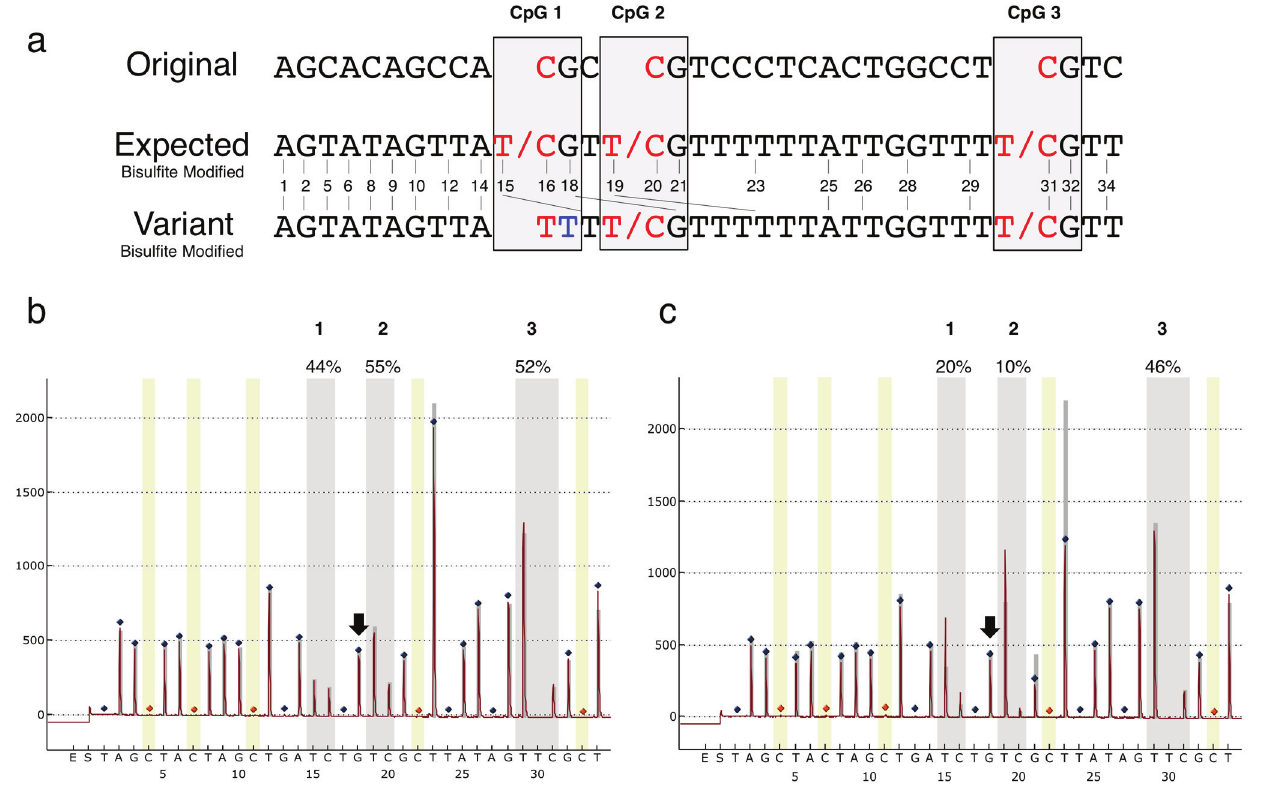
Figure 1. ( a ) The original sequence of interest for the IGF2 DMR region and the expected sequence from the bisulfite modified DNA and pyrosequencing, alongside the sequence for the variant allele. The three CpG dinucleotides are labeled; ( b ) Pyrogram obtained for an individual with wild type alleles; ( c ) Pyrogram from an individual with the variant allele, showing low methylation of CpG position 1 and a much higher than expected incorporation of T nucleotides at CpG 2 (position 19) due to the creation of a 3–4 base mononucleotide stretch of T residues. The number of T residues incorporated depends on the methylation status of the second CpG cytosine. This leads to premature incorporation of the downstream T nucleotides at position 19, early incorporation of the downstream G at position 21 instead at position 18 on the variant allele and as consequence only half the anticipated G height at the subsequent G at position 21, and lower than expected peak height for the Ts at position 23 since those on the variant allele had been incorporated at position 19. This also results in inaccuracy for the methylation status of the second CpG (site 20). The % methylation measured is indicated above each CpG cytosine. CpG cytosine positions are indicated by the grey vertical bars. Blue diamonds, non-variable reference peaks; orange diamonds with yellow background bar, bisulfite treatment control and reference peak; narrow grey bars behind peaks, theoretical histogram for the sequence to analyze. Methylation data for the IGF2 DMR was generated for n = 166 cervical cancer study specimens, of which n = 19 had the variant allele, and n = 1104 NEST cohort specimens, of which n = 50 had the variant